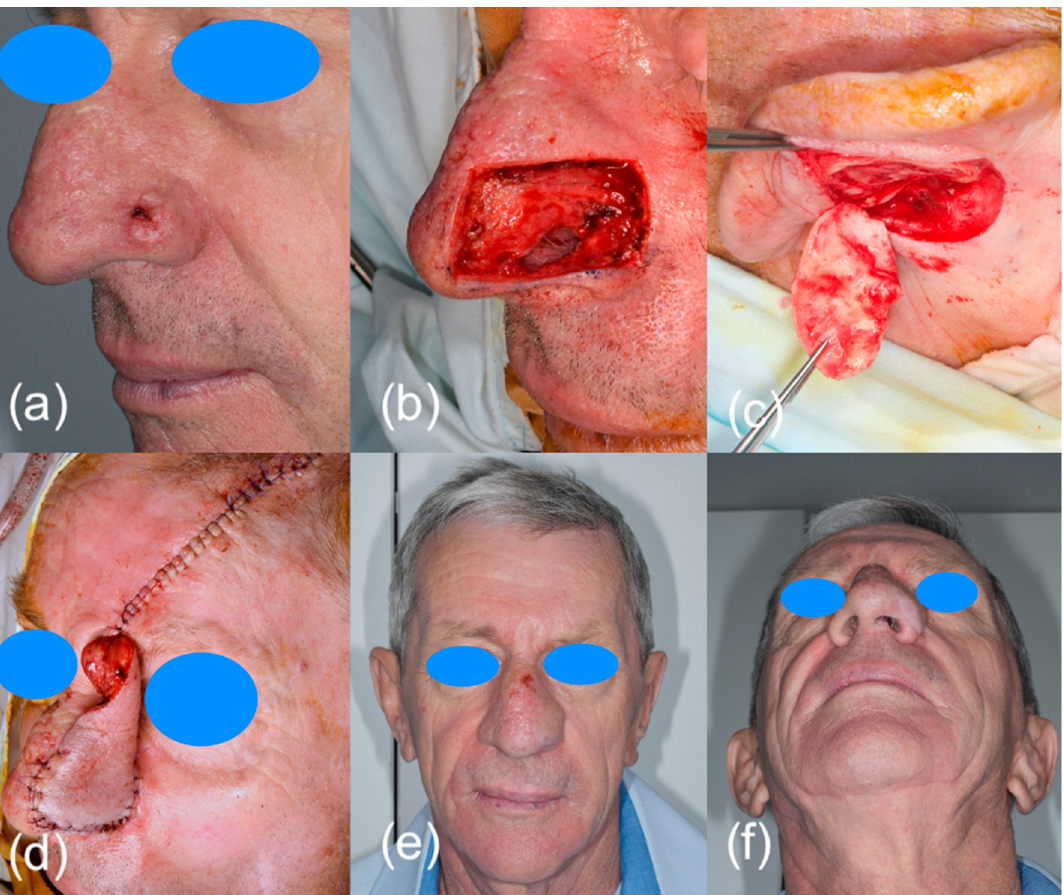
Figure 1. The same BCC examined with 13 MHz ( a ), 20 MHz ( b ) and 40 MHz ( c ). As the frequency increases, the presence of the two hyperechoyc spots is clearer.